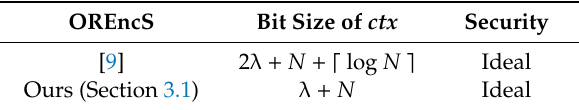
Table 1. Comparison of our order-revealing encryption for polynomially-sized domains (OREncS) scheme defined in Section 3.1 and the existing scheme of [9]. Note that this is the result when the same 1-bit output hash function is applied to their